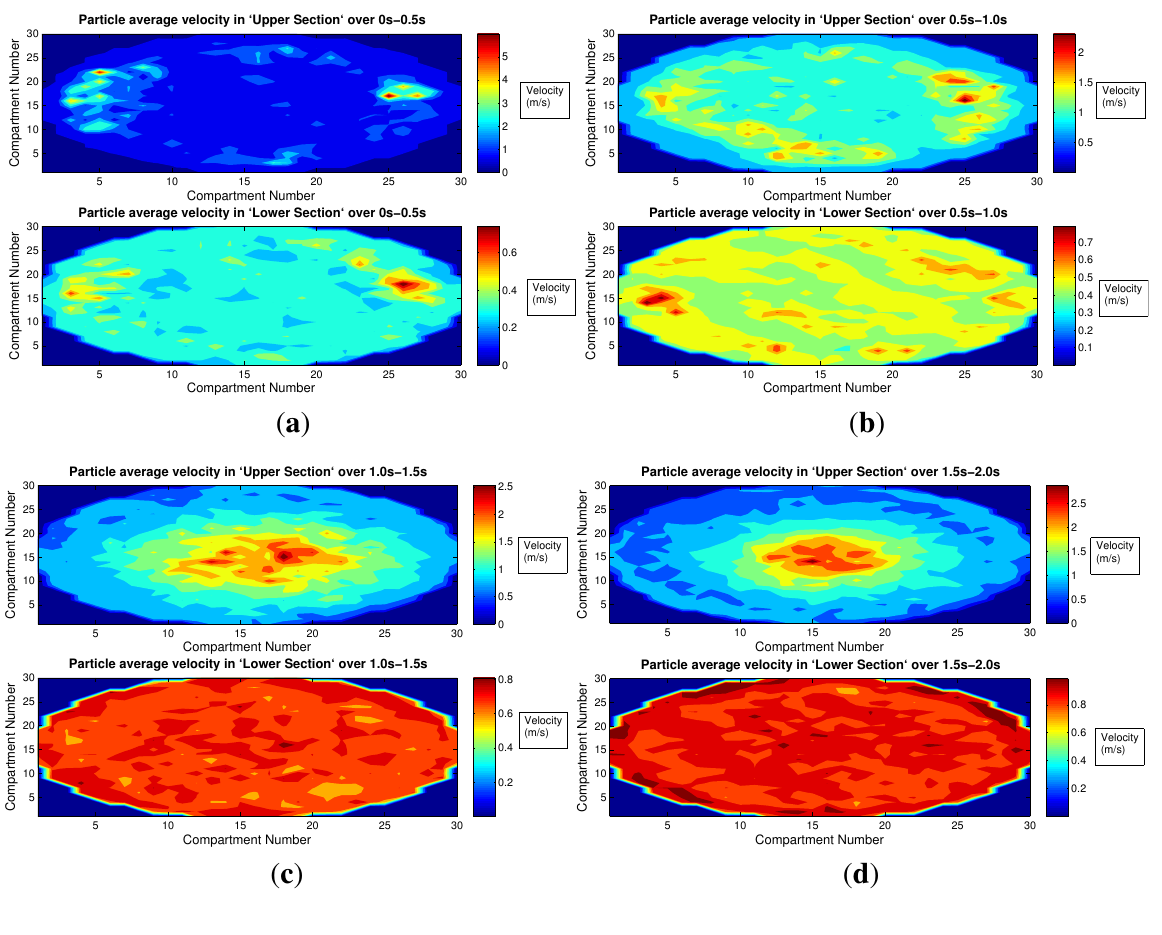
Figure 3. Velocity contour plots. ( a ) Velocity distribution over 0 s–0.5 s; ( b ) Velocity distribution over 0.5 s–1.0 s; ( c ) Velocity distribution over 1.0 s–1.5 s; ( d ) Velocity distribution over 1.5 s–2.0 s.